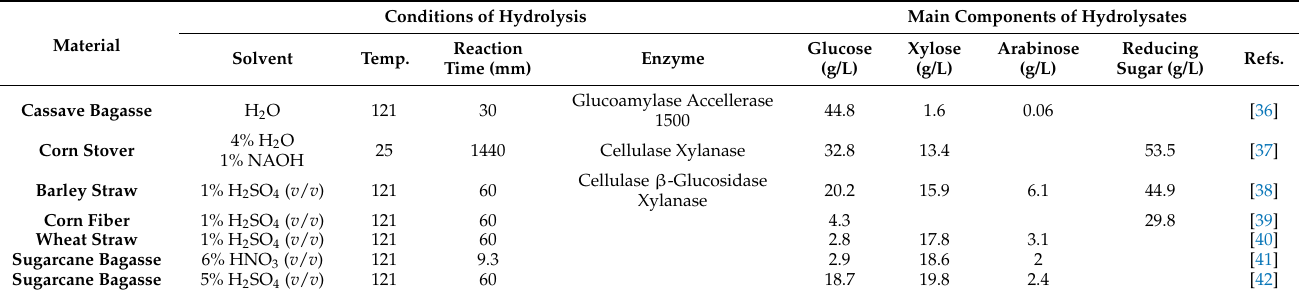
Table 1. Comparison of main components of biomass hydrolysates from different biomass source. Conditions of Hydrolysis Main Components of Material